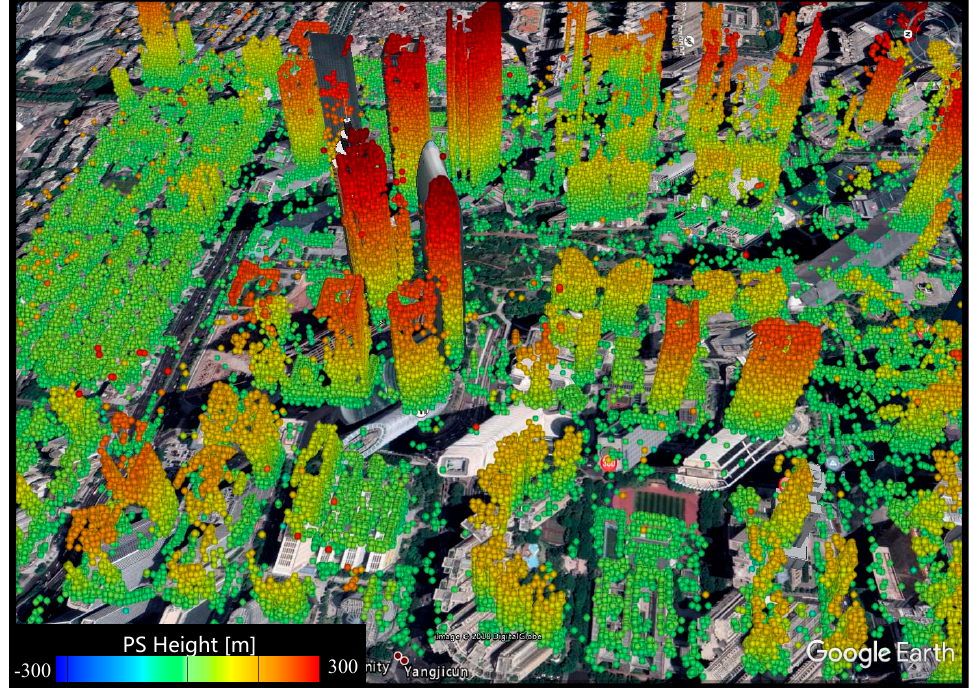
Figure 12. 3D-visualization of PS-InSAR results, using the proposed processing method.